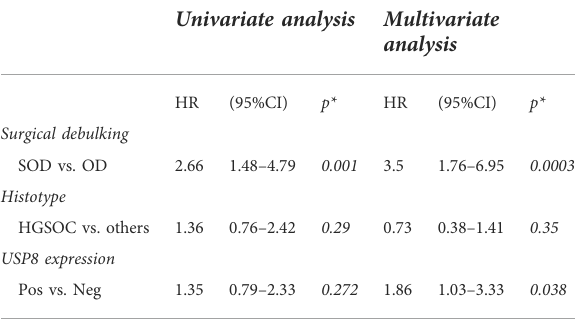
TABLE 3 Univariate and multivariate analysis (Cox regression) of PFS for clinical and biological (USP8) variables. a Univariate analysis Multivariate